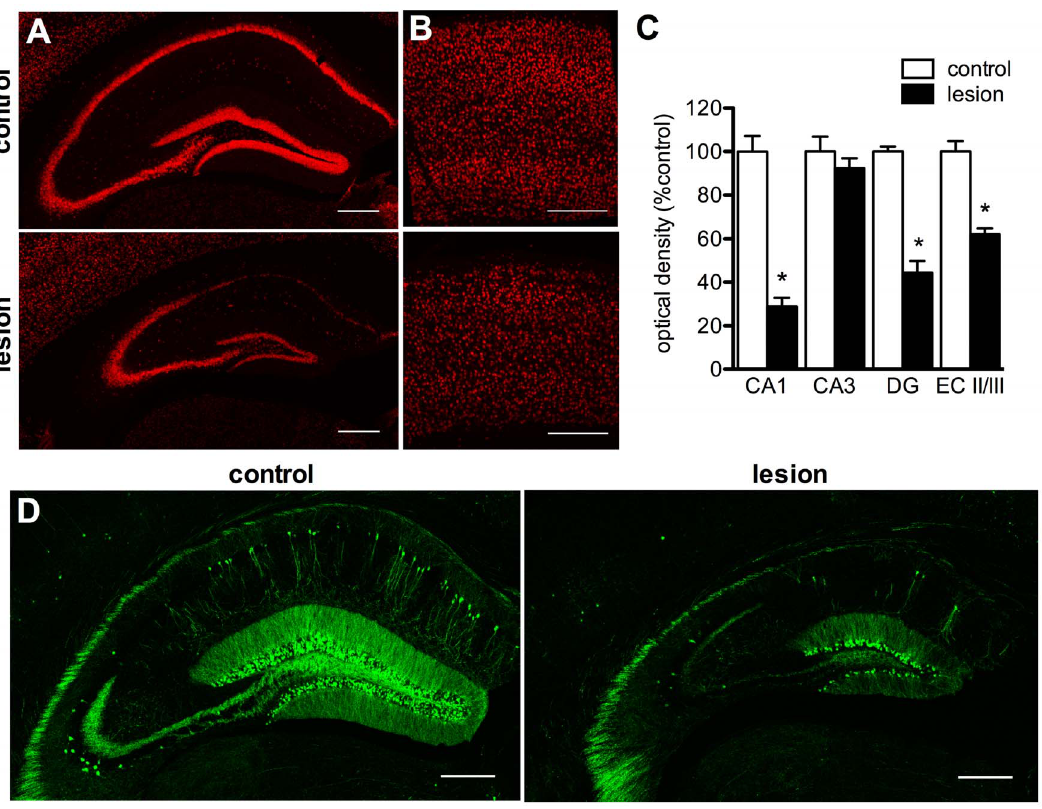
Figure 1. CaM/Tet-DT A mice develop neuronal loss in Alzheimer-disease related brain areas. A 25-day withholding of doxycycline from the diet of CaM/Tet-DT A mice induces DT A expression, which causes a selective loss of hippocampal and cortical neurons. Representative images depict a significant loss of NeuN immunoreactivity in the CA1 and DG of the hippocampus ( A ), and layers II/III of the entorhinal cortex ( B , n =5–6, quantified by optical densitometry in C ). Crossing CaM/Tet-DT A mice with mice carrying a Thy1-GFP-M transgene produces sparse GFP-labeling of CA1 pyramidal neurons ( D ). Scale bars=1 mm.